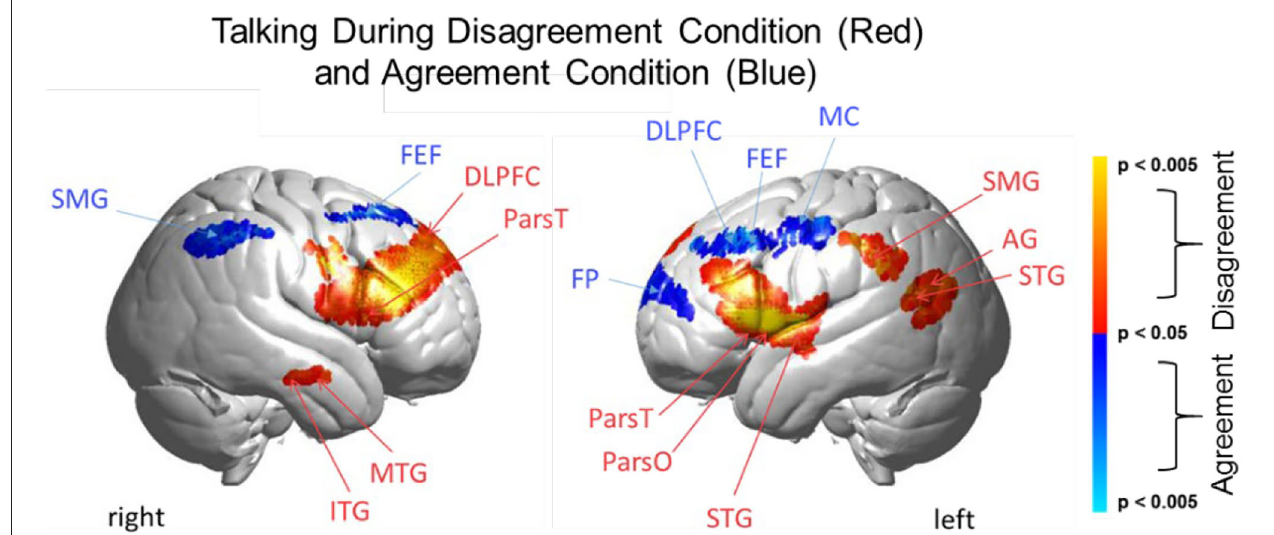
FIGURE 6 | Talking condition. Brain activity clusters represent functions of Disagreement [talking > listening] (red) and Agreement [talking > listening] (blue). Neural systems most active during talking and disagreement conditions (red) include bilateral frontal regions [DLPFC, dorsolateral prefrontal cortex; ParsT, pars triangularis, ParsO, pars opercularis]. Left hemisphere SMG, supramarginal gyrus; AG, angular gyrus; STG, superior temporal gyrus are also included. Neural systems most active during talking and agreement conditions (blue) include bilateral FEF, frontal eye fields right SMG, supramarginal gyrus and left FP, frontopolar activity. See Table 5 . TABLE 5 | GLM contrast comparison: talking [Disagree > Agree] with ASE co-regressor, (deOxyHb signals).